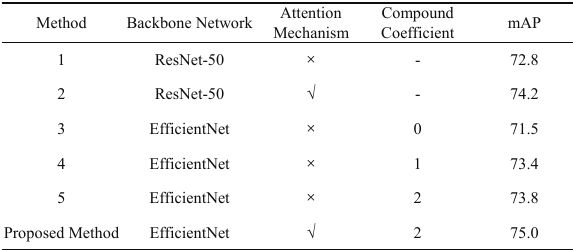
Table 3. The mean average precisions of ablation